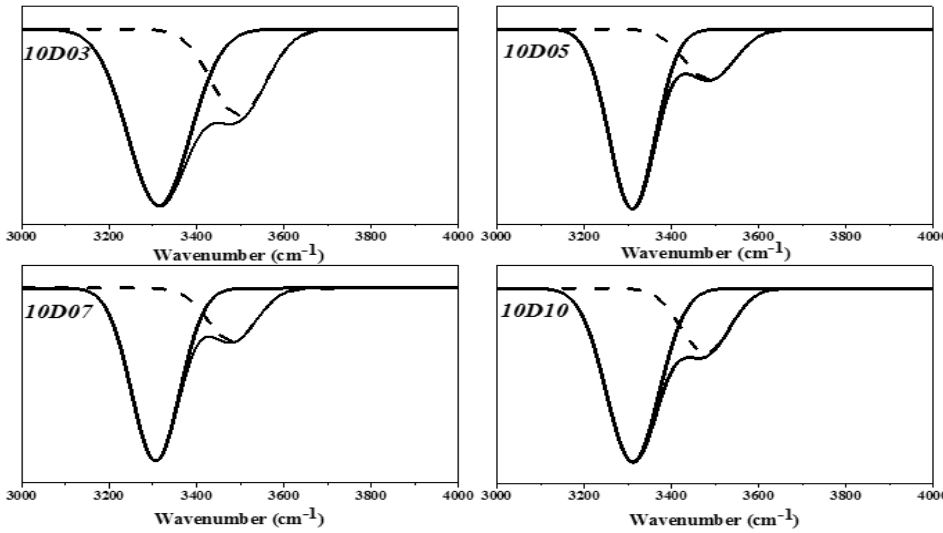
Figure 4 . Simulated peak splitting diagrams of FT-IR spectra of –C=O group .